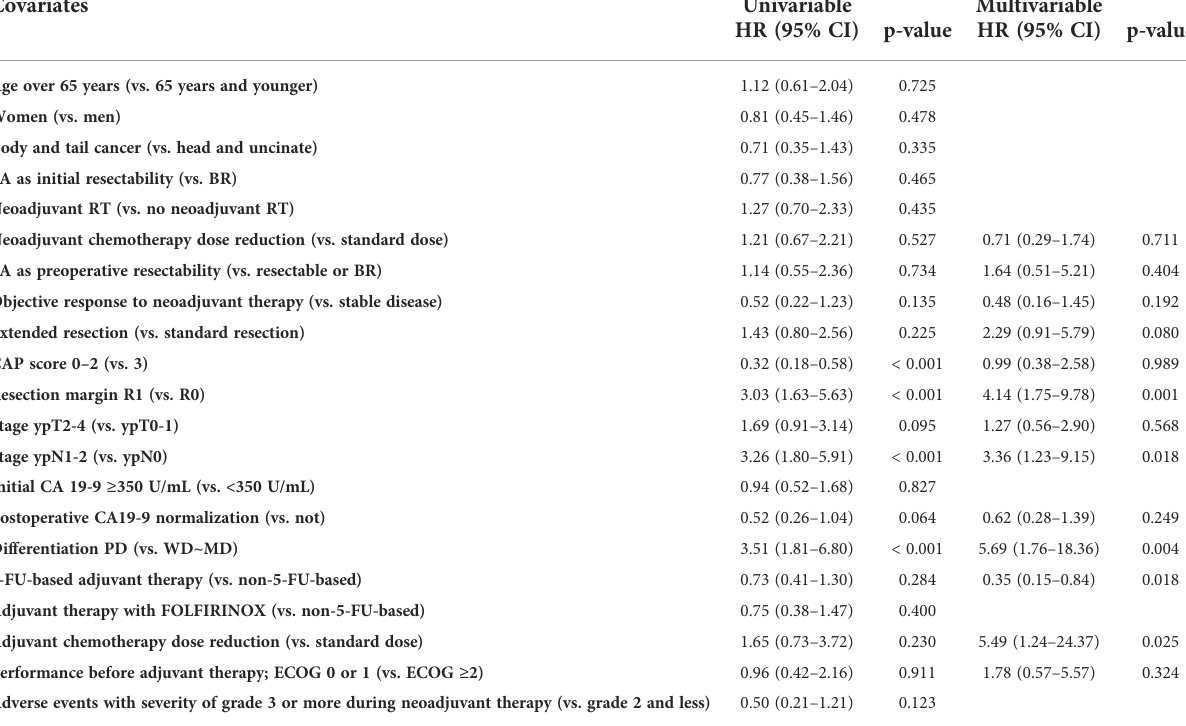
TABLE 4 Prognostic factors for death by multivariable Cox proportional hazards analysis.